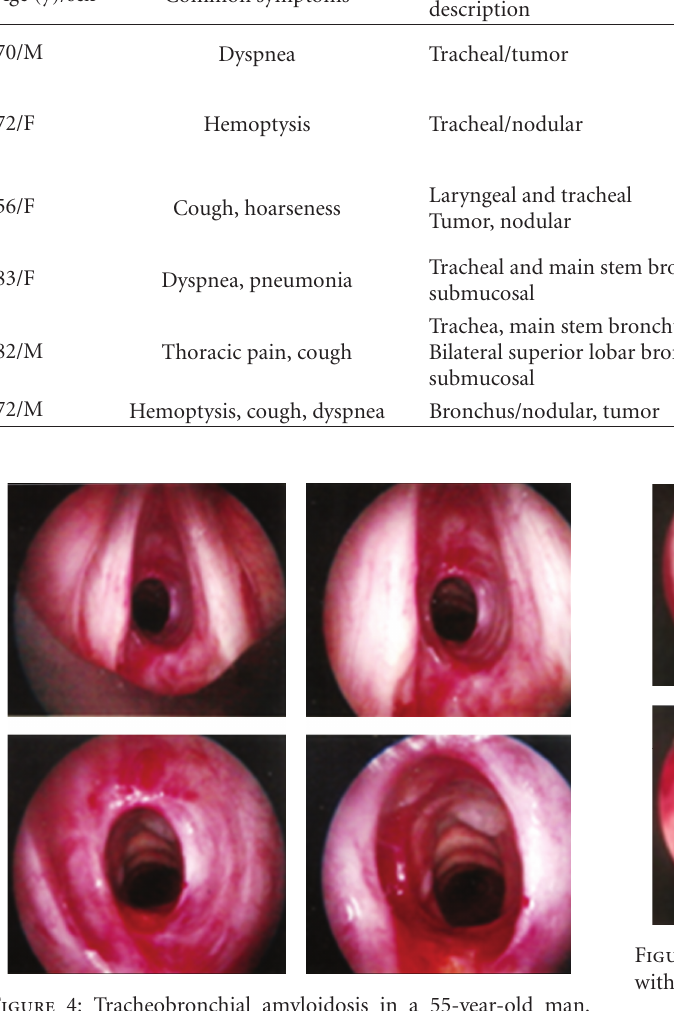
Figure 4: Tracheobronchial amyloidosis in a 55-year-old man. Bronchoscopic image shows subglottic stenosis and irregular mucosal thickening with di ff use nodular deposits that involve all portions of the trachea.